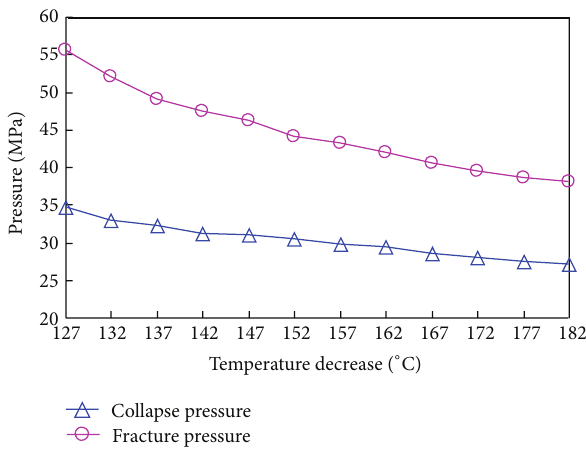
Figure 24: Risk distribution of collapse pressure when temperature drop is 25 ∘